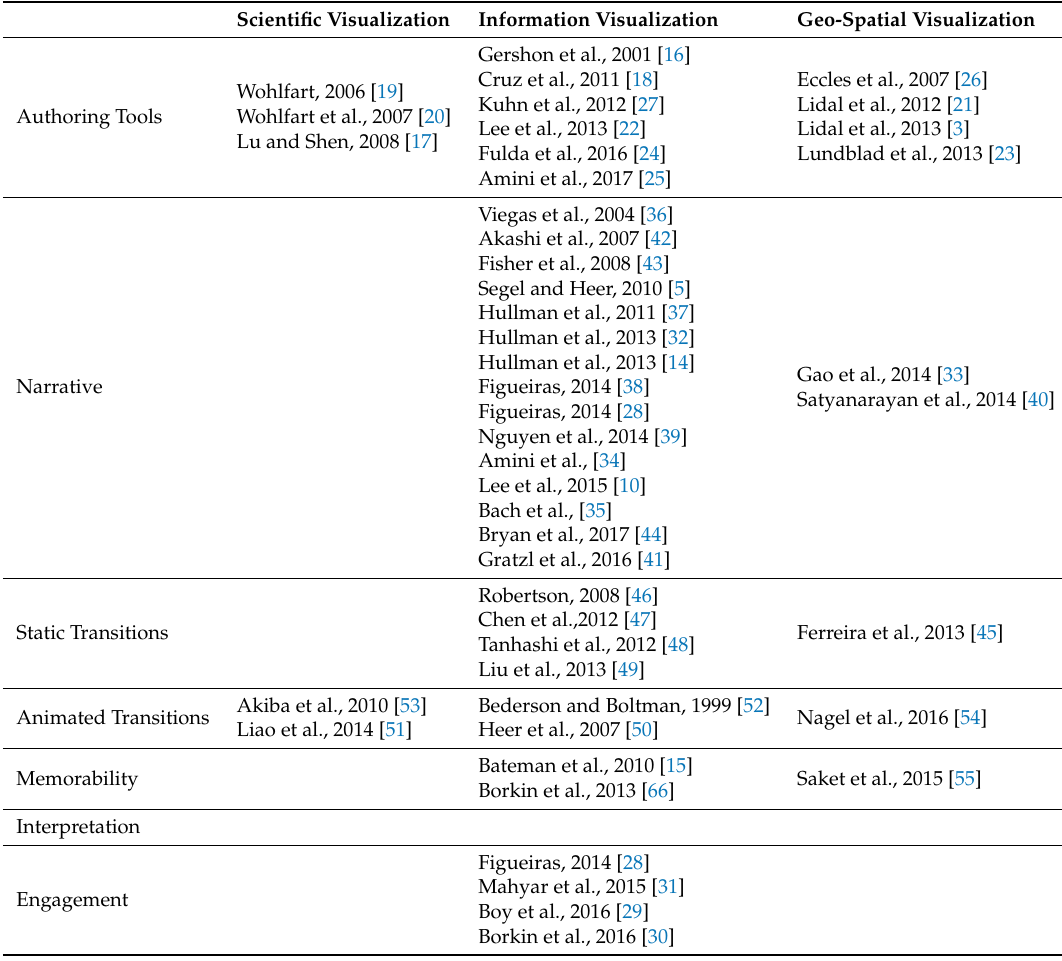
Table 2. An alternative classification of the storytelling literature based on scientific, information, and geo-spatial visualization. Both mature areas and unsolved problems are